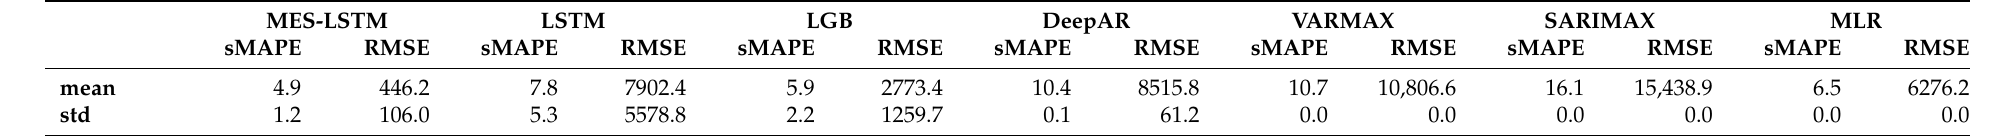
Table 9. Forecast Accuracy Distribution for All Trials for total deaths in South